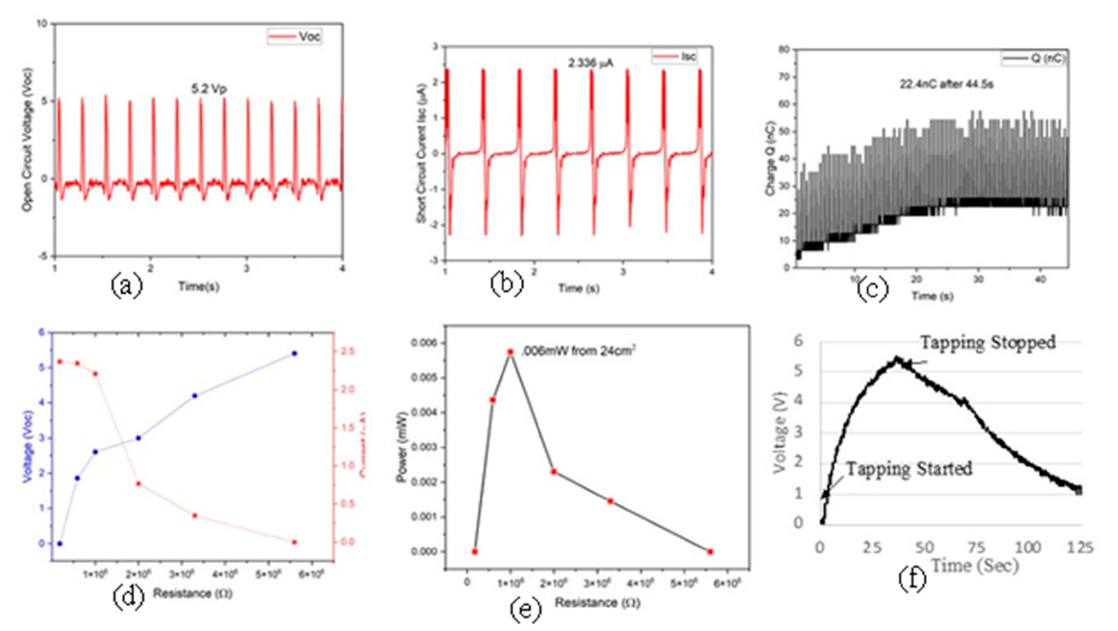
Figure 4. Output performance of the sensor by repetitive tapping pressure: ( a ) open circuit voltage; ( b ) short circuit current; ( c ) charge accumulation over tapping time; ( d ) real-time change in voltage and current due to the corresponding change in the resistive load; ( e ) the correlation of the power generation against different resistances; and ( f ) the charging and discharging behaviour of the device under tapping start/stop.